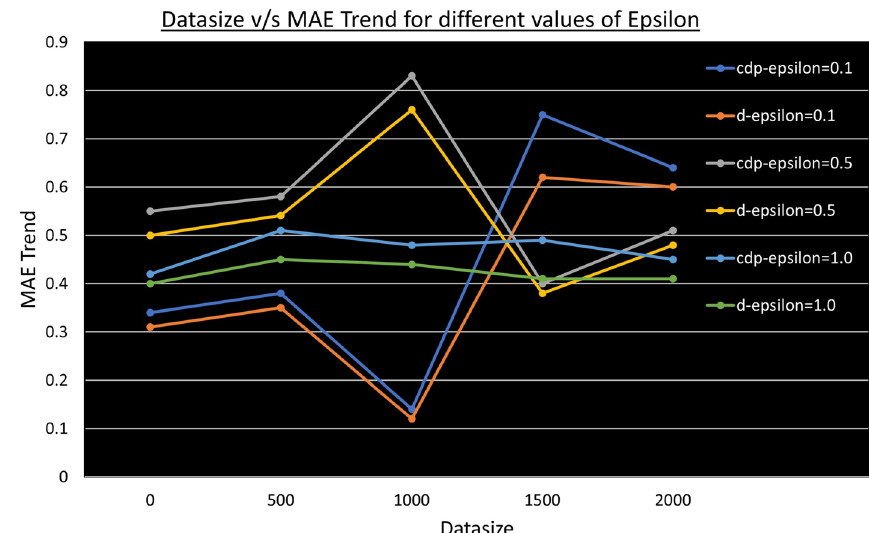
Fig. 12 Datasize versus MAE trend for the different